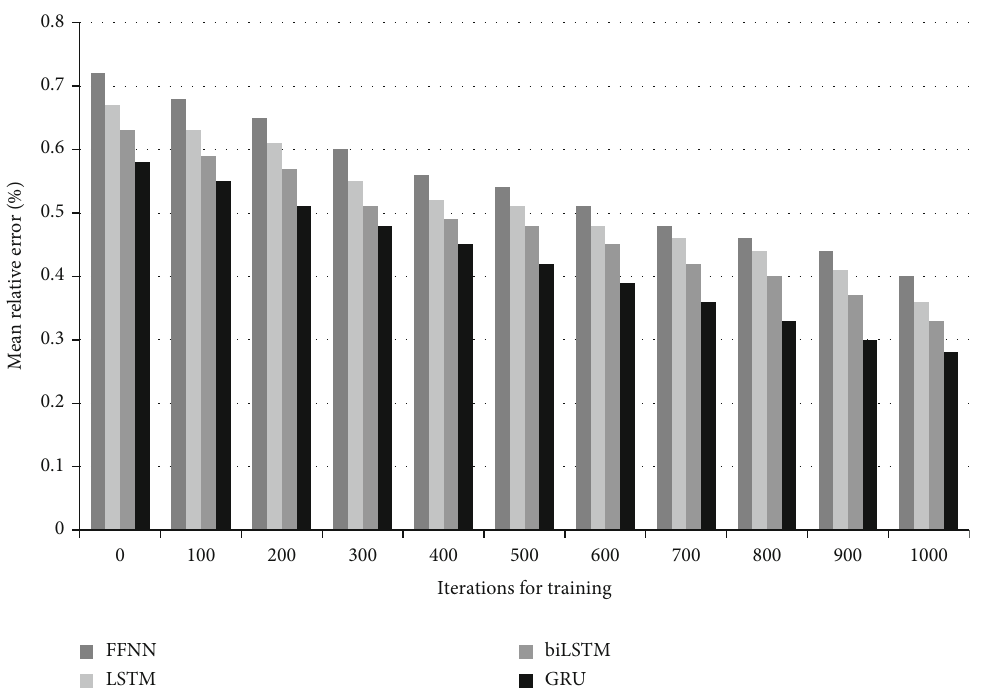
Figure 7: MRE values obtained by diverse techniques in de fi ned iterations.